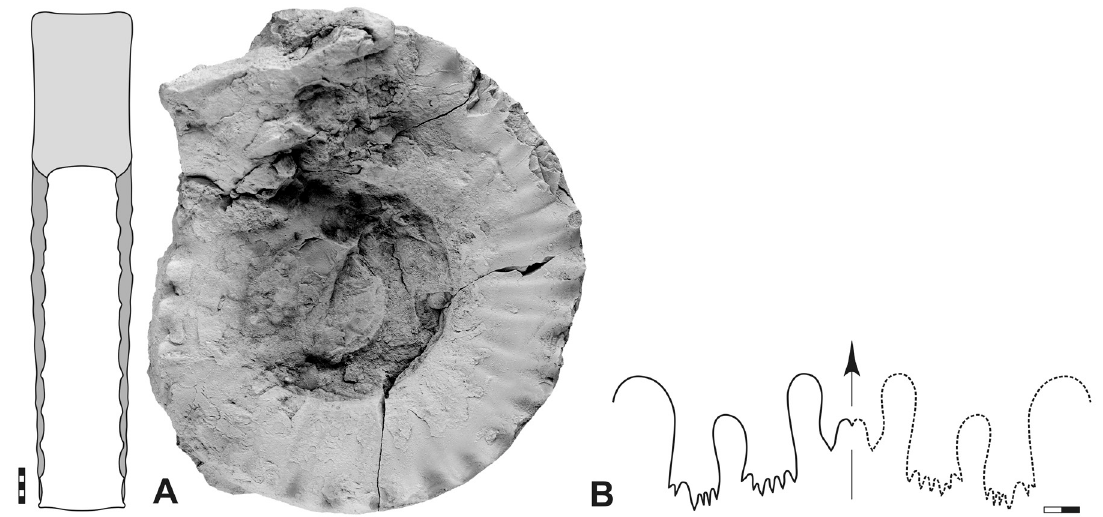
Fig. 63. Stoyanowites parallelus Korn & Hairapetian sp. nov. A . Lateral and dorsal view, holotype MB.C.30102, section C, -1.70 m. B . Suture line, holotype MB.C.30102, at 17.5 mm wh. Abbreviation: see Material and methods. Scale bar units = 1 mm.